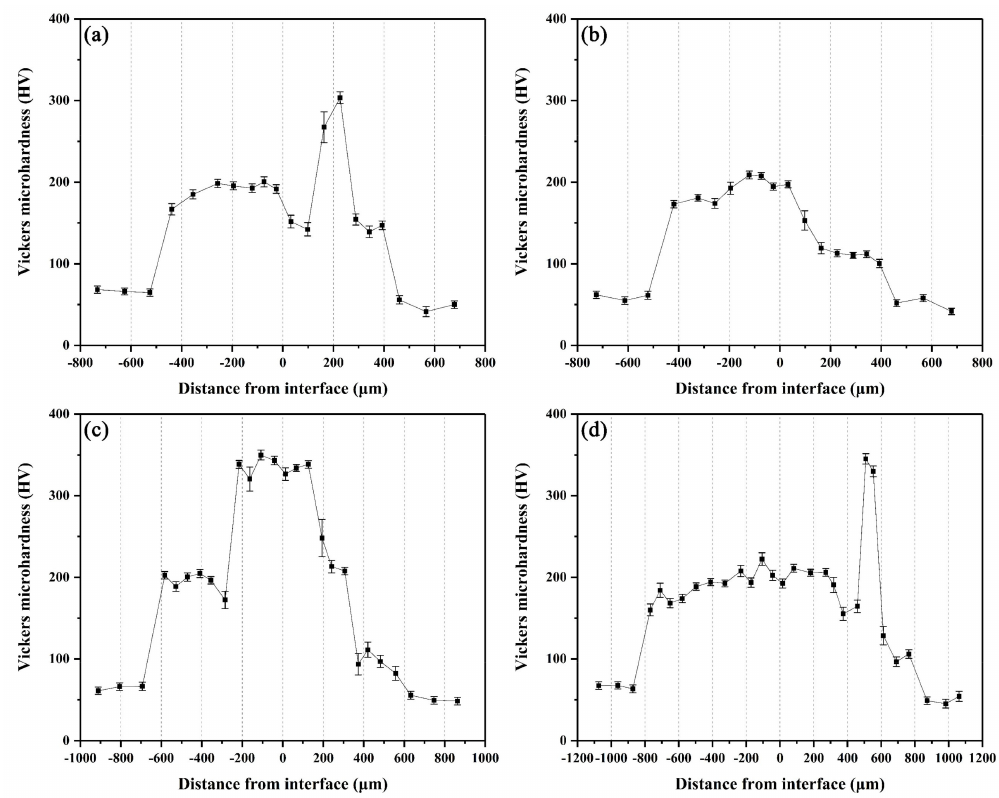
Figure 14. Vickers microhardness profiles across the interfaces of arc-sprayed Al / AZ91D with a Zn interlayer: ( a ) S18H6, ( b ) S18H12, ( c ) S30H6, and ( d )